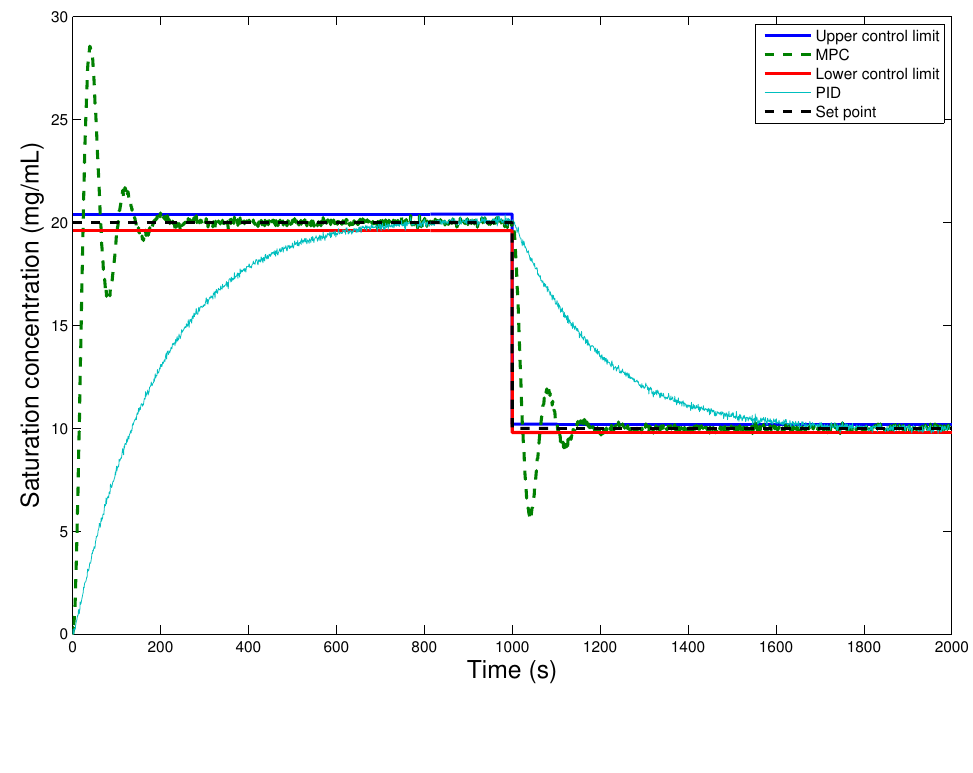
Figure 6. Controller performance evaluation for the set point tracking of the saturation concentration.